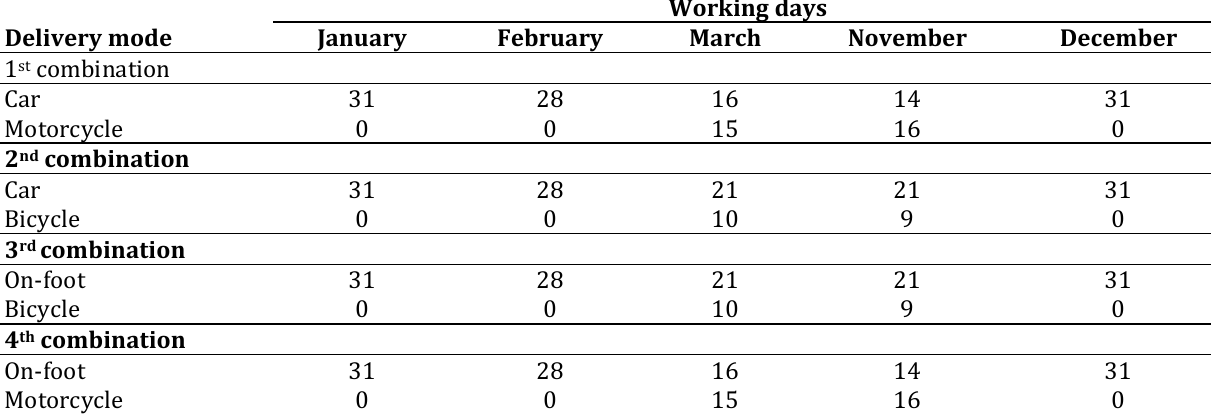
Table 5: Numbers of working day for each combination of city delivery modes for season with difficult weather conditions